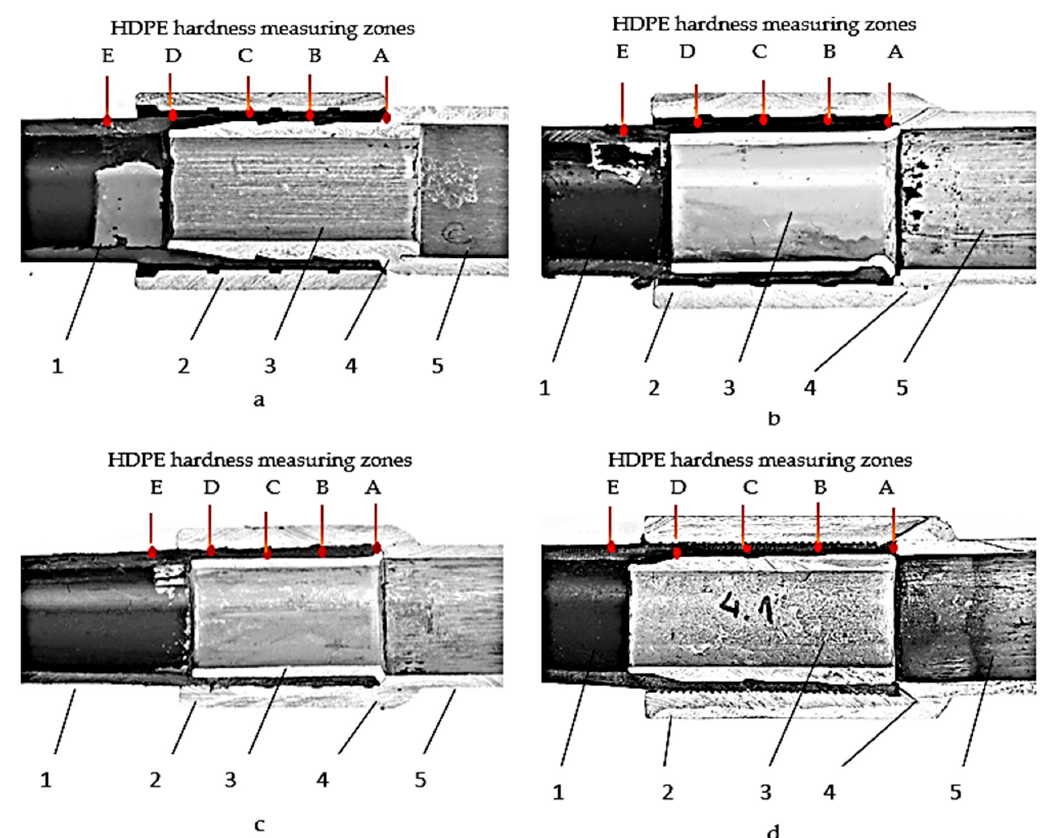
Figure 1. Types of transition fittings obtained: ( a )—T1 transition fittings; ( b )—T2 transition fitting; ( c )—T3 transition fitting; ( d )—T4 transition fitting; 1—HDPE pipe; 2—outer bush; 3—inner bush; 4—welding bead; 5—steel pipe.